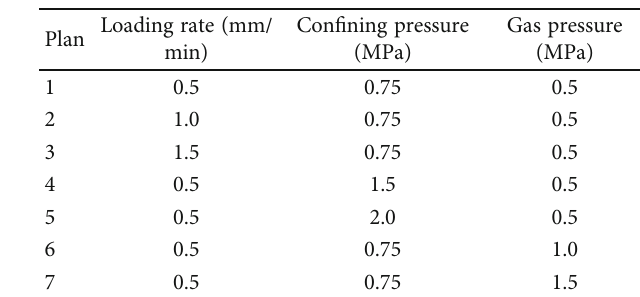
Table 1: Experimental